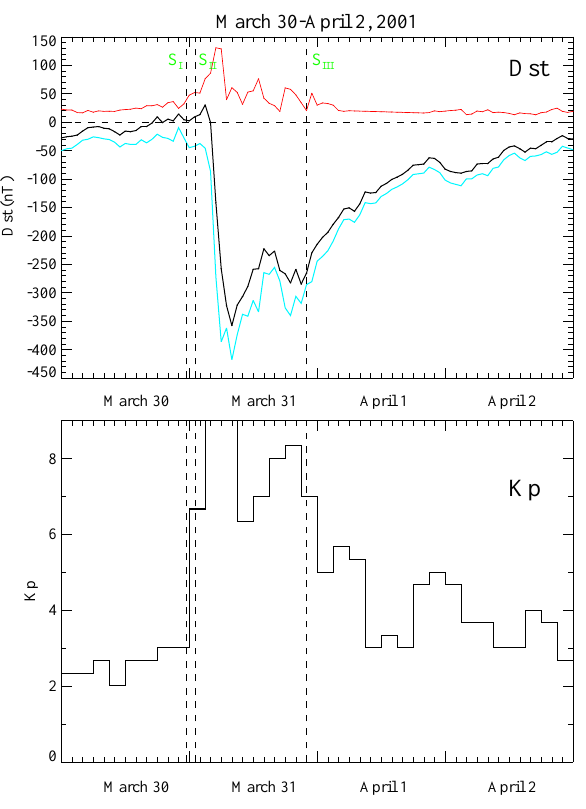
Fig. 11. Similar to Fig. 10 but for the shorter interval 30 March–2 April.